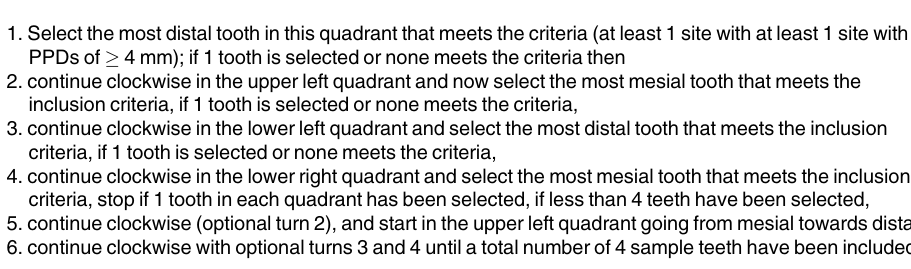
Fig 2. Sample tooth selection. Selection process: According to the randomization list, sample teeth are selected in a clockwise (CW) or counter clockwise (CC) direction. Example: For clockwise selection, start at the upper right quadrant from the most distal tooth going towards the mesial (CW, mandatory turn